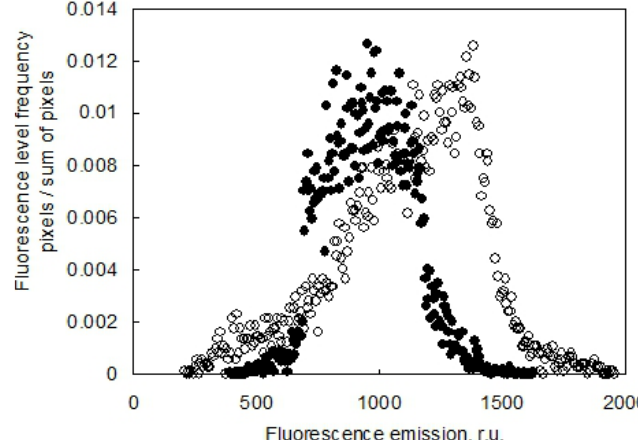
Figure 10. Distribution of steady state (Fs) chlorophyll fluorescence emission of a pepper leaf. Open symbols [ ○ ] show the distribution of fluorescence as recorded by FluorCam image while closed symbols represent the same values corrected for the leaf inclination [ ● ]. The 3D corrected data were calculated by renormalizing the fluorescence signal by cosine of the angle between the normal to the leaf surface and the optical axes of the